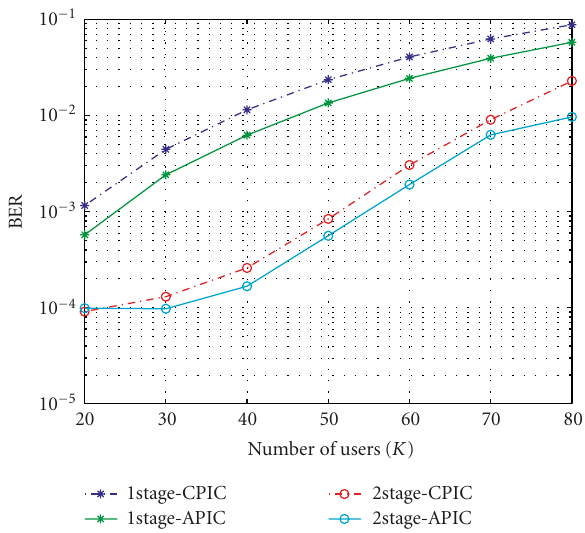
Figure 6: BER performance of one stage APIC receiver with di ff er- ent initial weights as a function of the step-size, N = 32, SNR = 20 dB, K = 30.